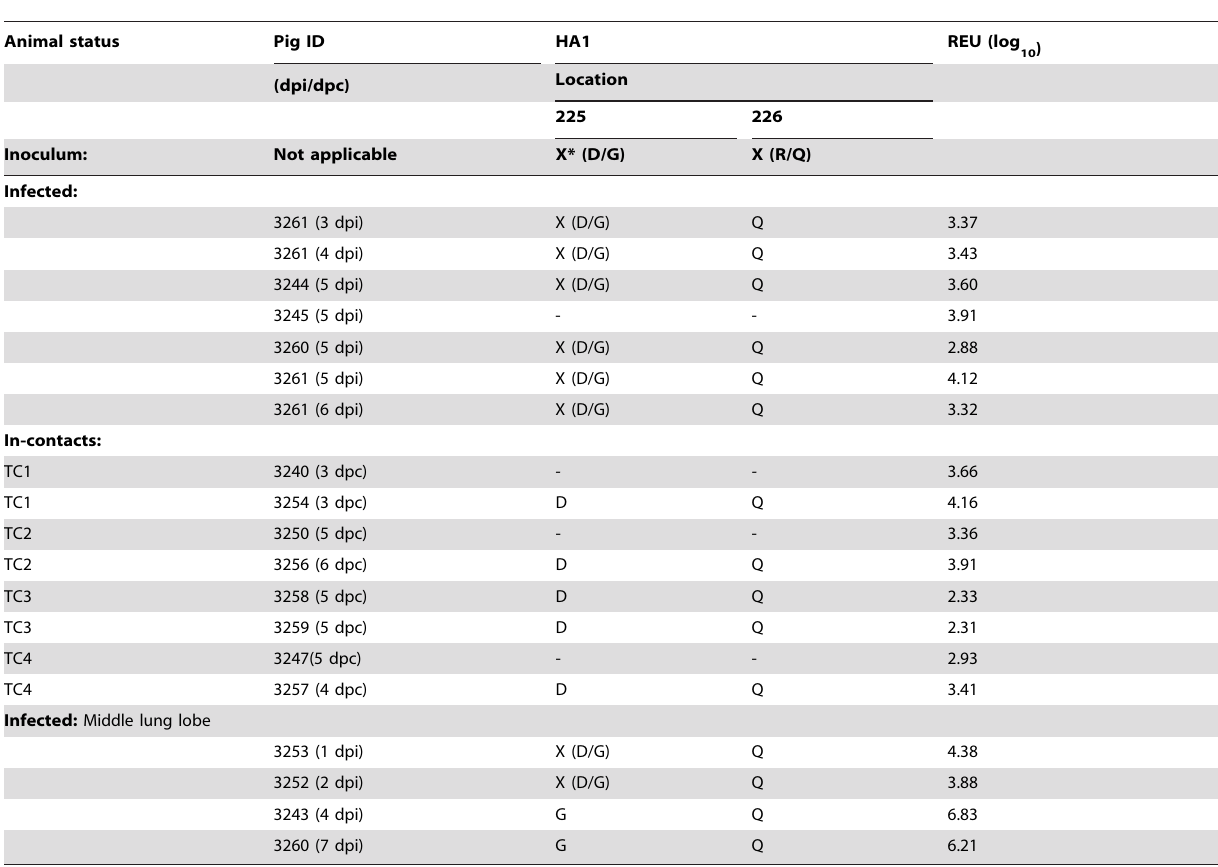
Table 2. HA1 locations at which amino acid changes were observed in directly infected and contact pigs.